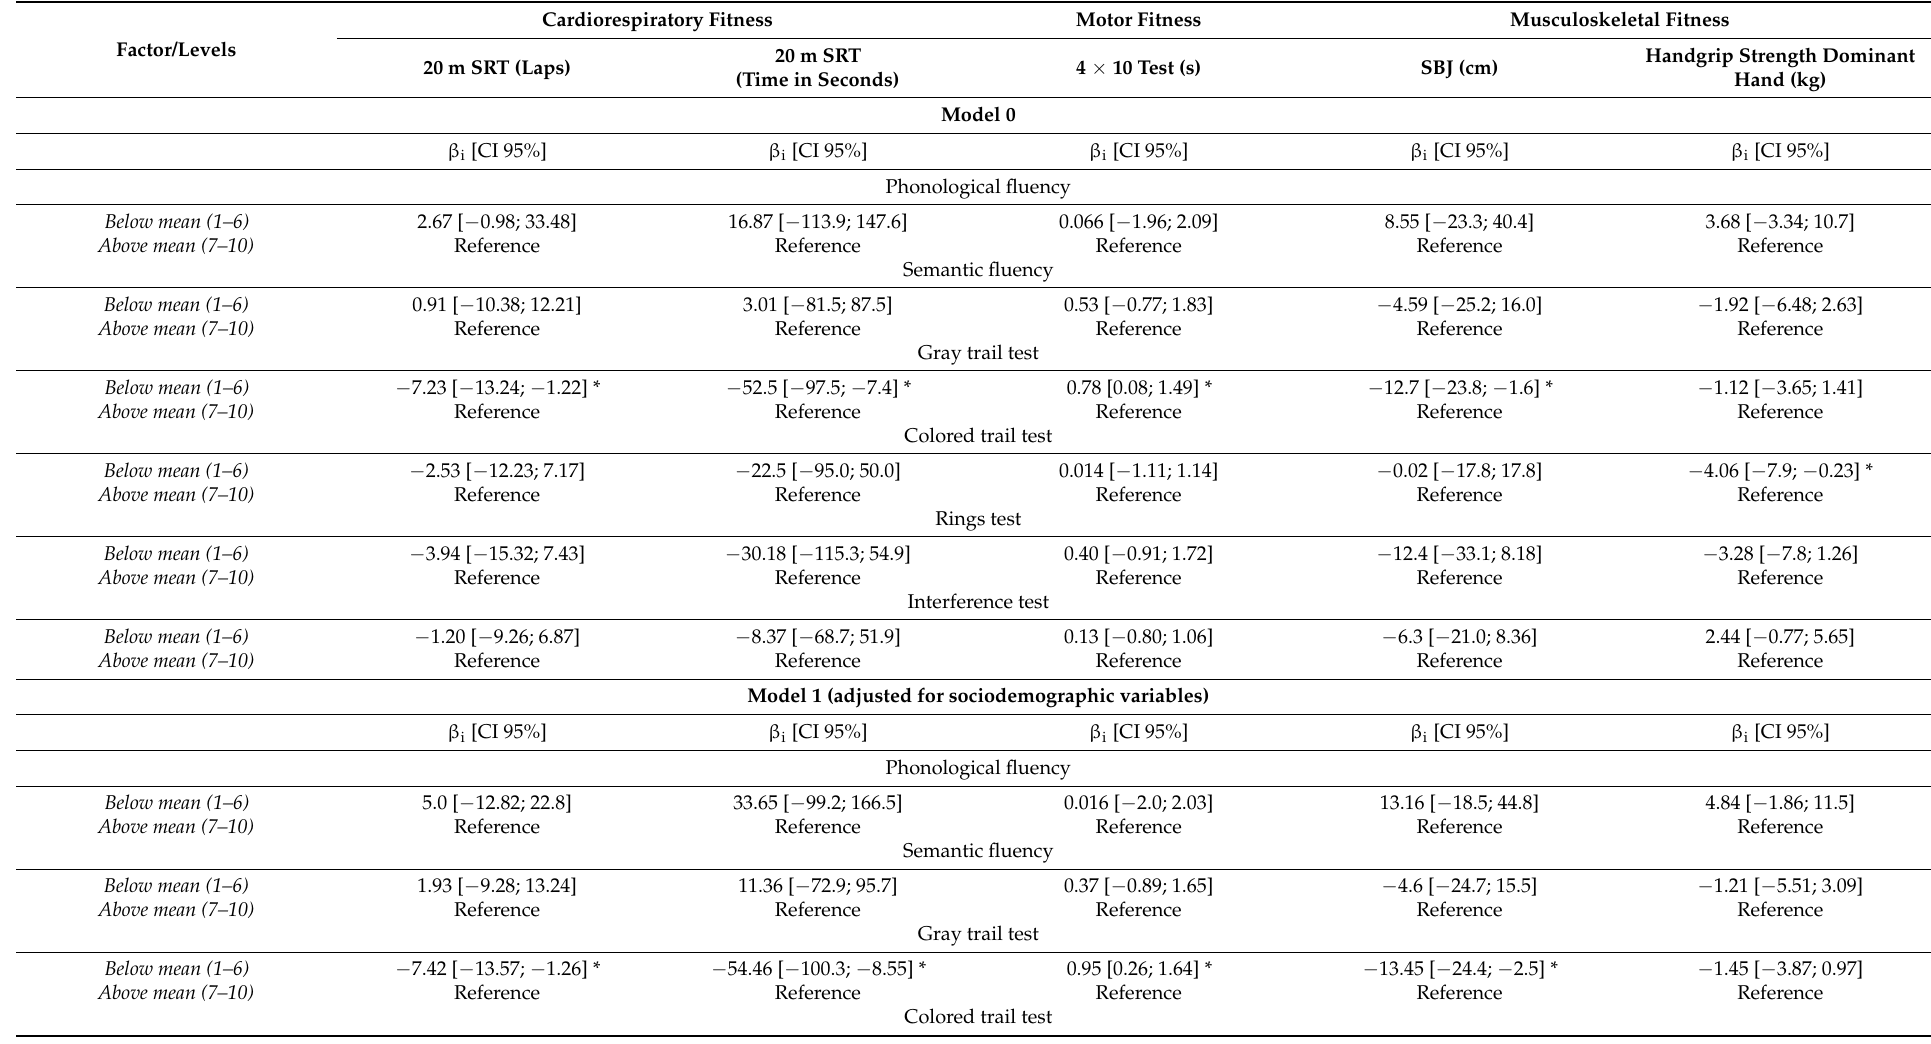
Table 4. Association between executive function and performance in physical